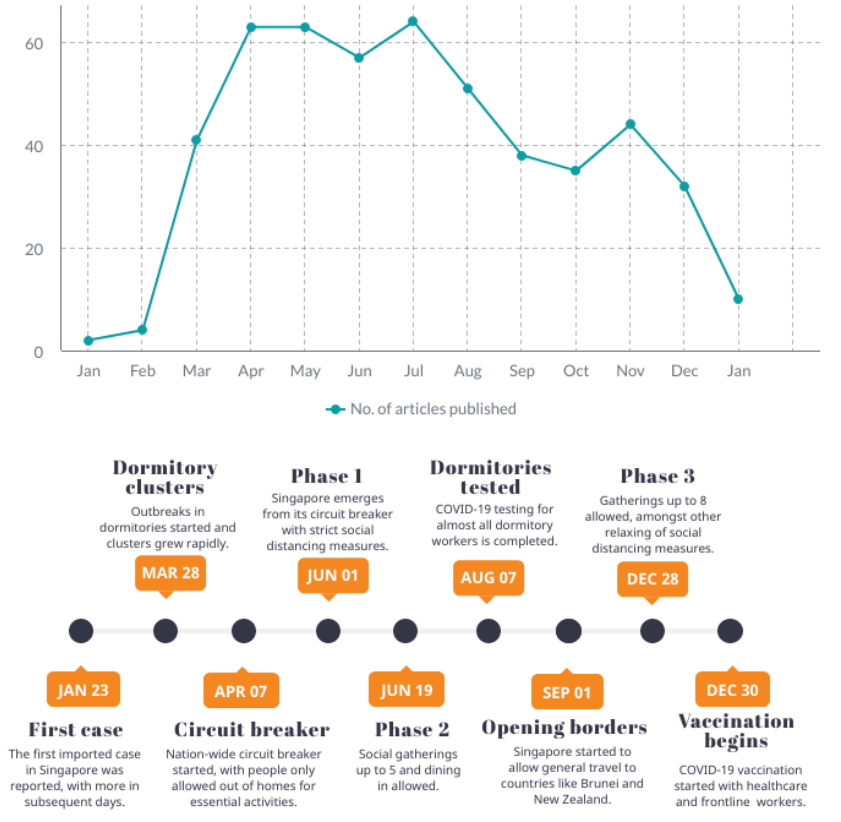
Figure 2. Articles published per month and a timeline of the first year of the COVID-19 pandemic.